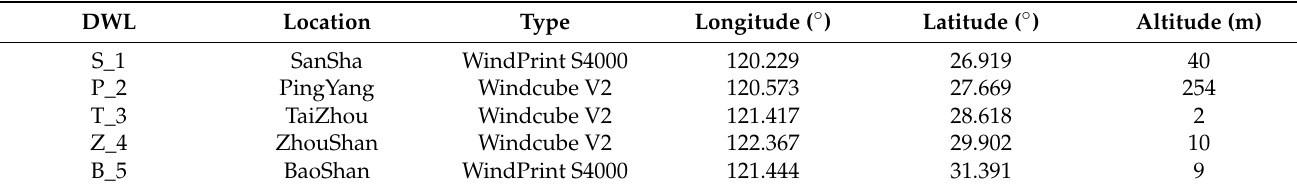
Table 1. Details of DWL type and location of the observation